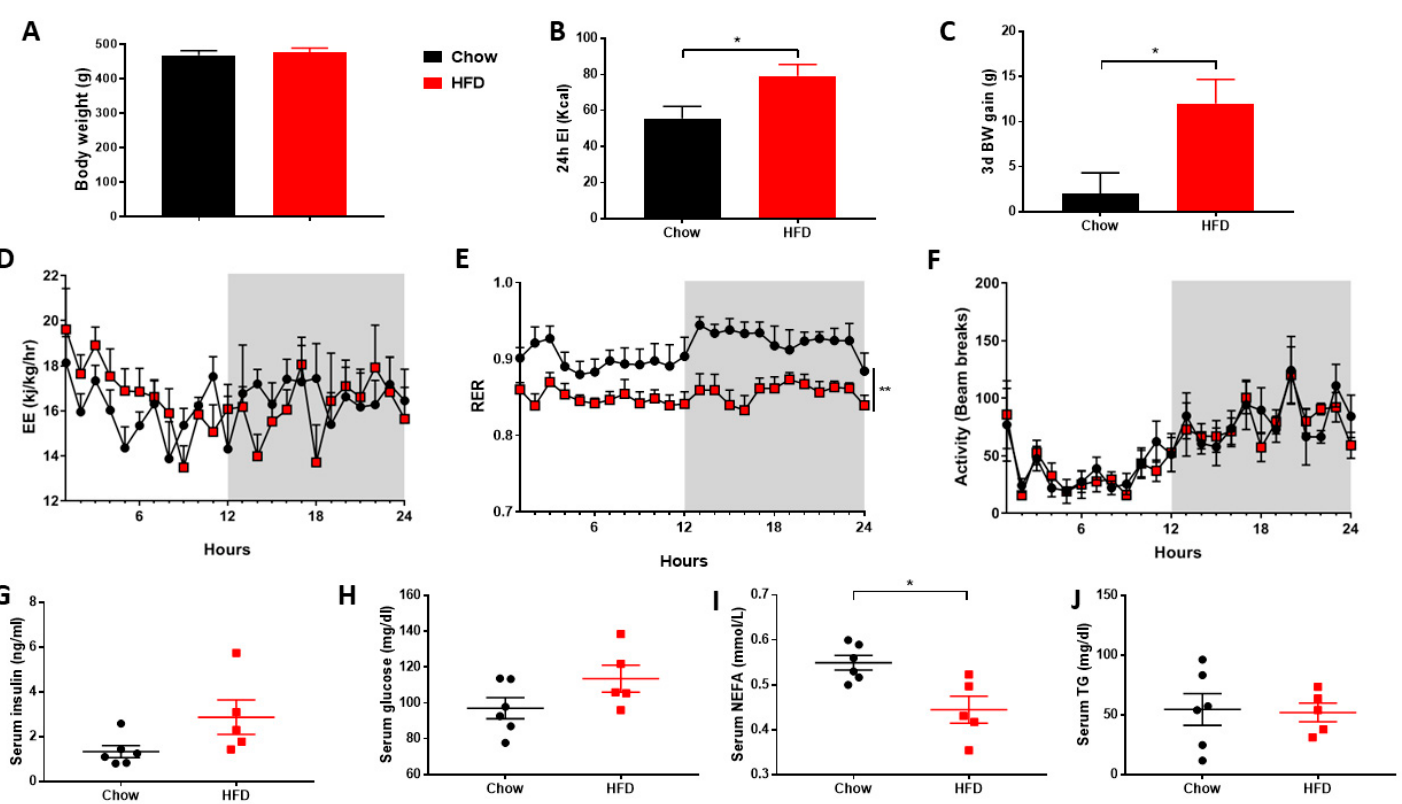
Figure 1. High fat diet (HFD) modified total energy balance but had no e ff ect on insulin, glucose, triglycerides or non-esterified fatty acids. ( A ) Final body weight, ( B ) 24h energy intake, ( C ) 3 day weight gain, ( D ) 24h energy expenditure (EE), respiratory exchange ratio (RER) and ambulatory activity and ( G – J ) serum metabolites. Data expressed as mean ± SEM, n = 6 per group. For comparison, data was analysed by either Students t -test ( A – C , G – J ) or two-way ANOVA ( D ) and Sidak post-hoc tests. Significance denoted as * < 0.05; ** < 0.01 or *** < 0.001.